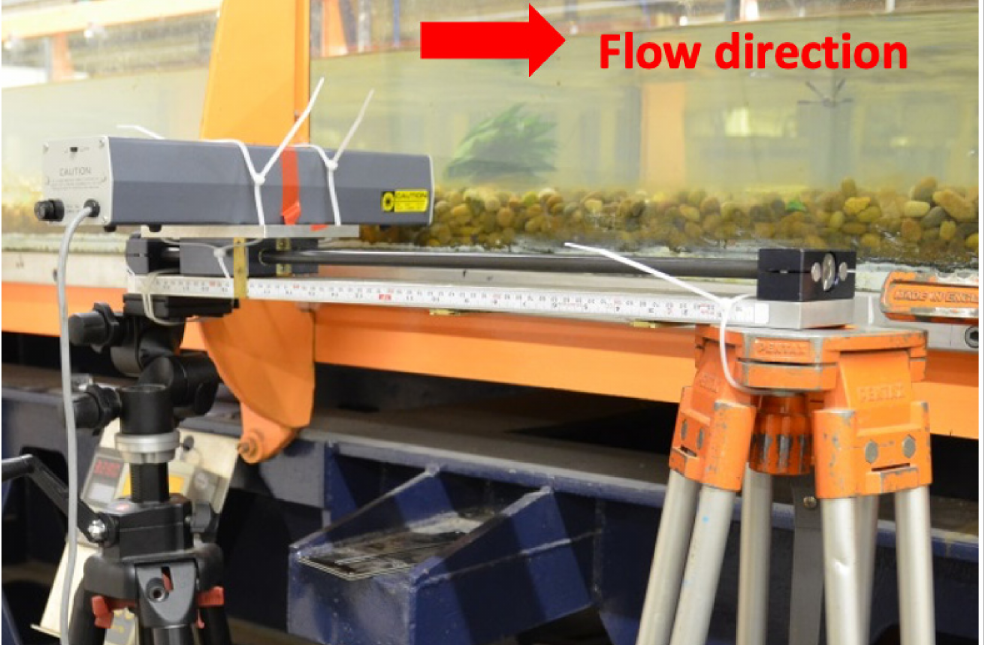
Figure 9. Side-view of the flume with the He-Ne laser and camera partially targeting the exposed particle downstream of the live vegetation